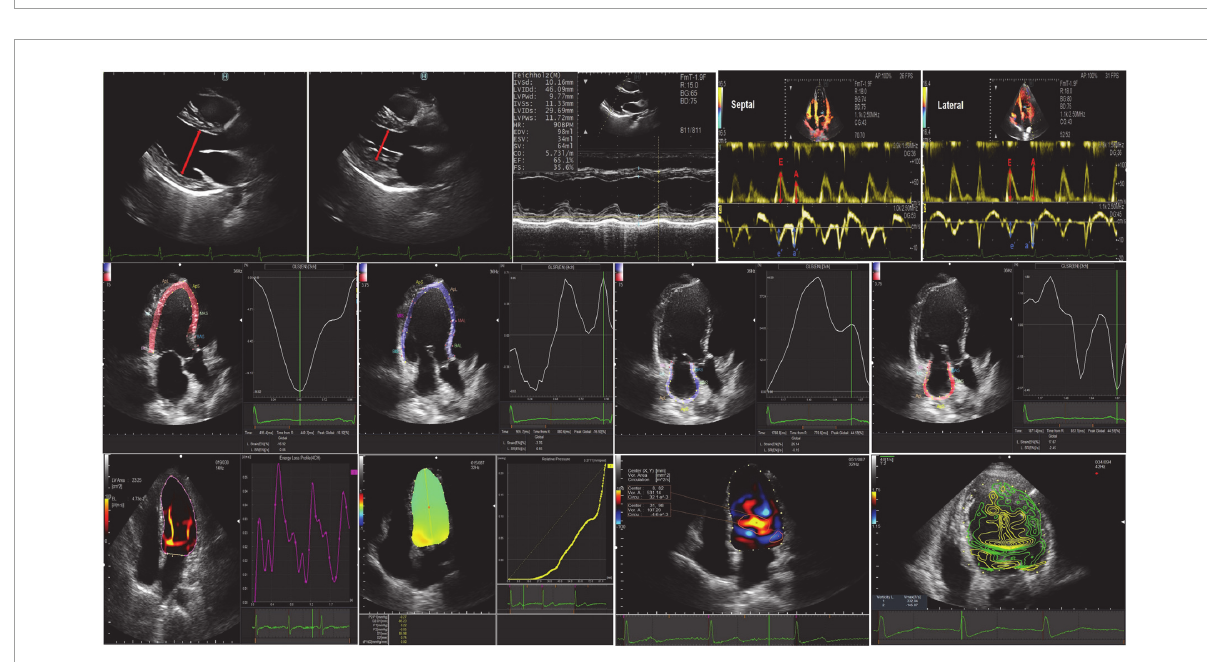
FIGURE2 Conventional echocardiography, speckle-tracking echocardiography, and vortex flow mapping